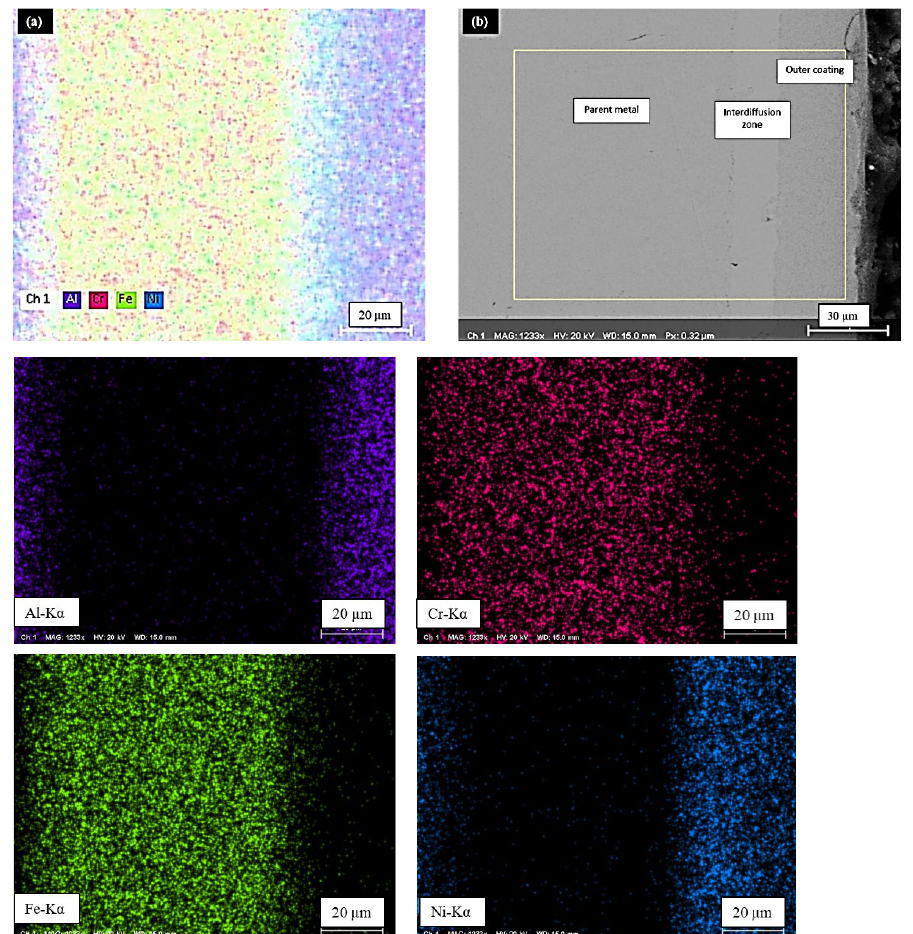
Figure 4. The SEM micrograph of the coating cross-section ( left ) along with corresponding line scan of the same ( right ). The distribution of the elemental species of Ni, Al, Cr, and Fe throughout the entire thickness of the aluminized sample is shown Figure 4b, whereas their elemental distribu- tion is shown in Figure 5a,b.